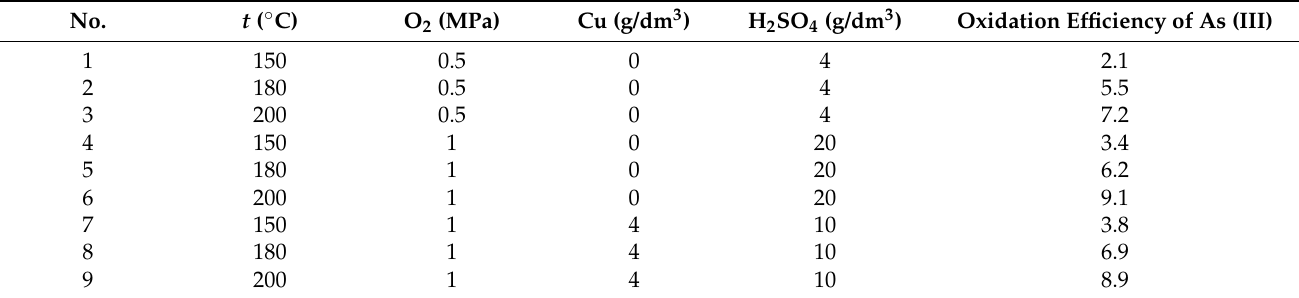
Table 1. Oxidation efficiency of As (III) to As (V) in the absence of iron ions in the solution.